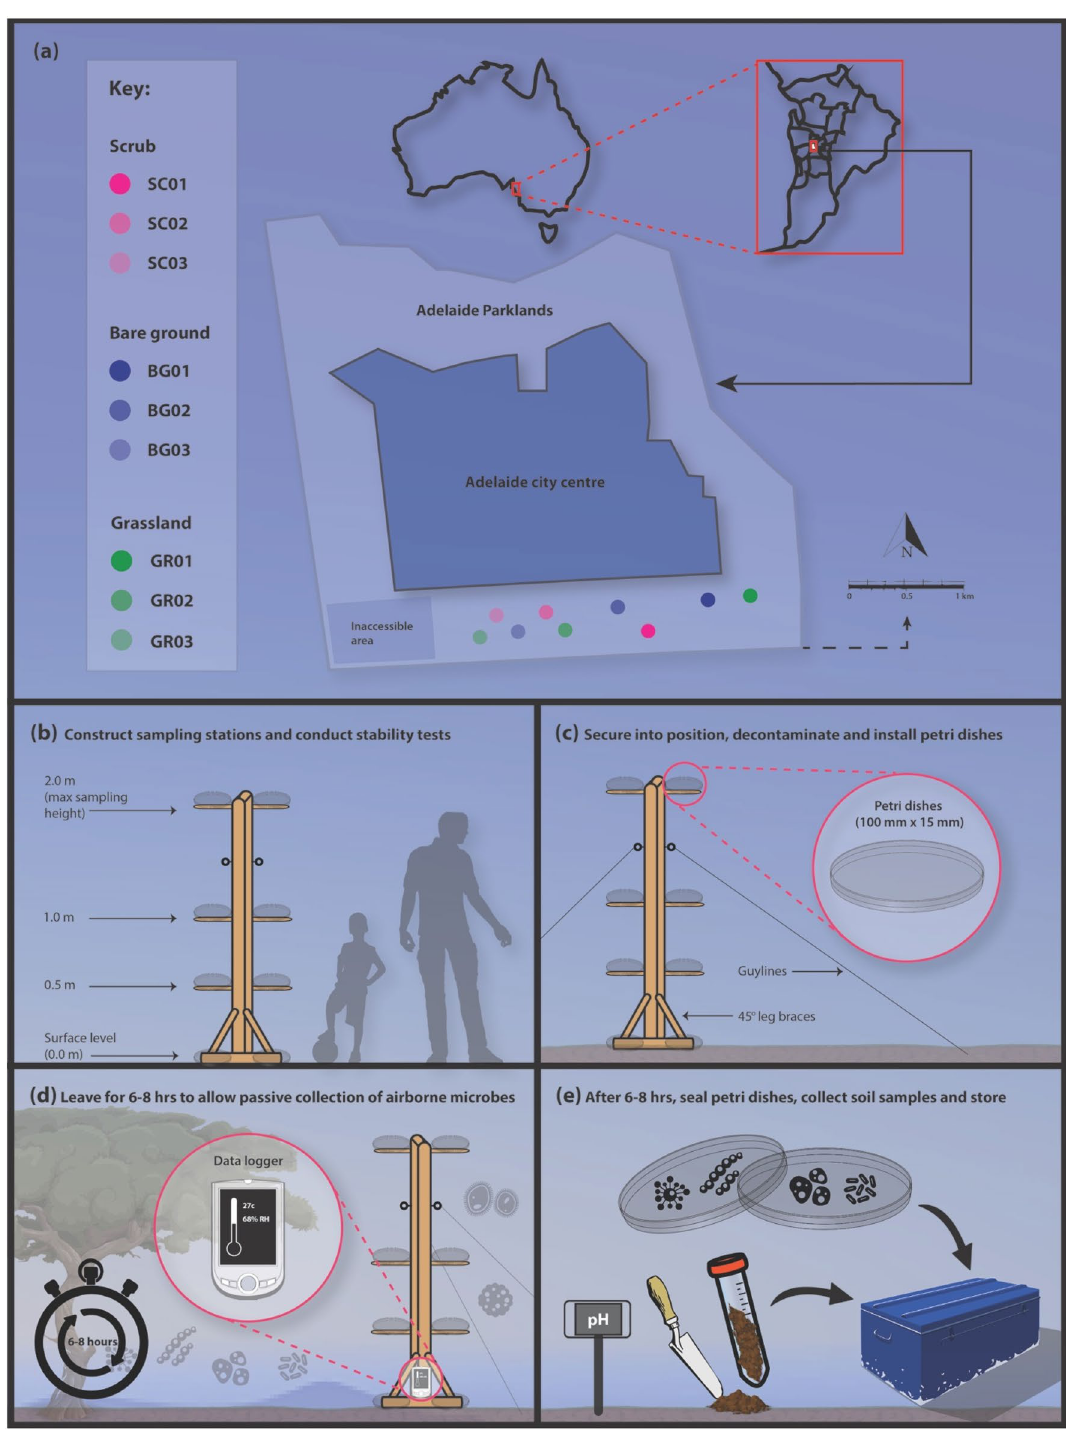
Figure 8. ( a ) Location of study sites, showing the different habitat types and randomly selected sampling locations. ( b – e ) Vertical stratification sampling station and methods used to collect (passively) air and (actively) soilborne bacteria. We installed the stations in three different habitat types in the Adelaide